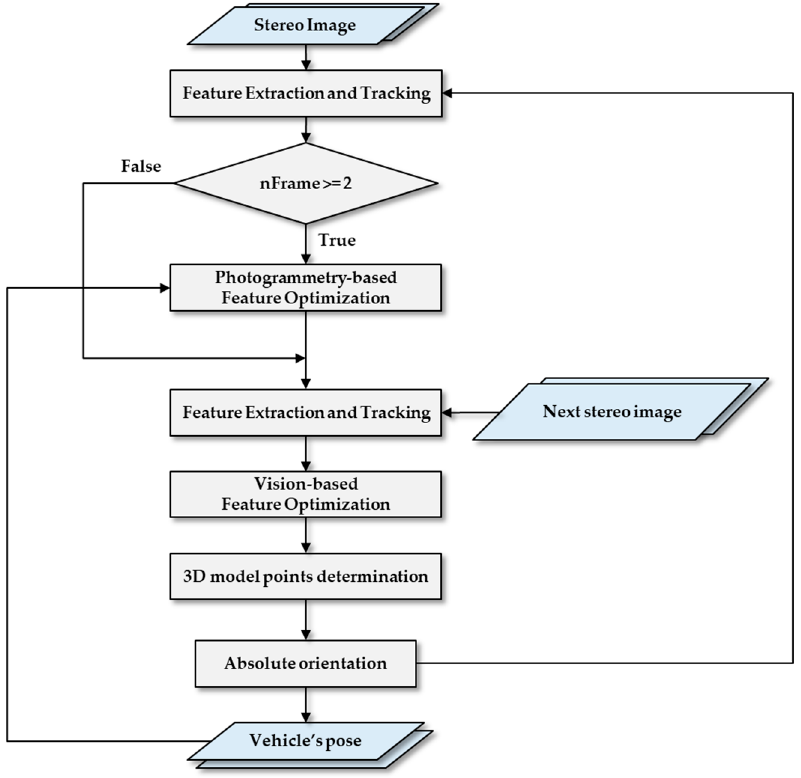
Figure 2. Procedure for proposed method.